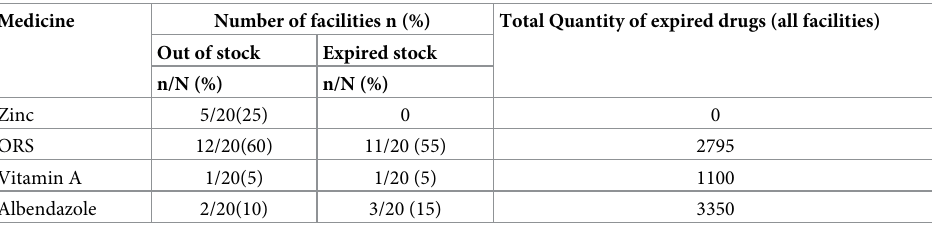
Table 2. Essential medicines stock (physical count) at the facilities on the visit